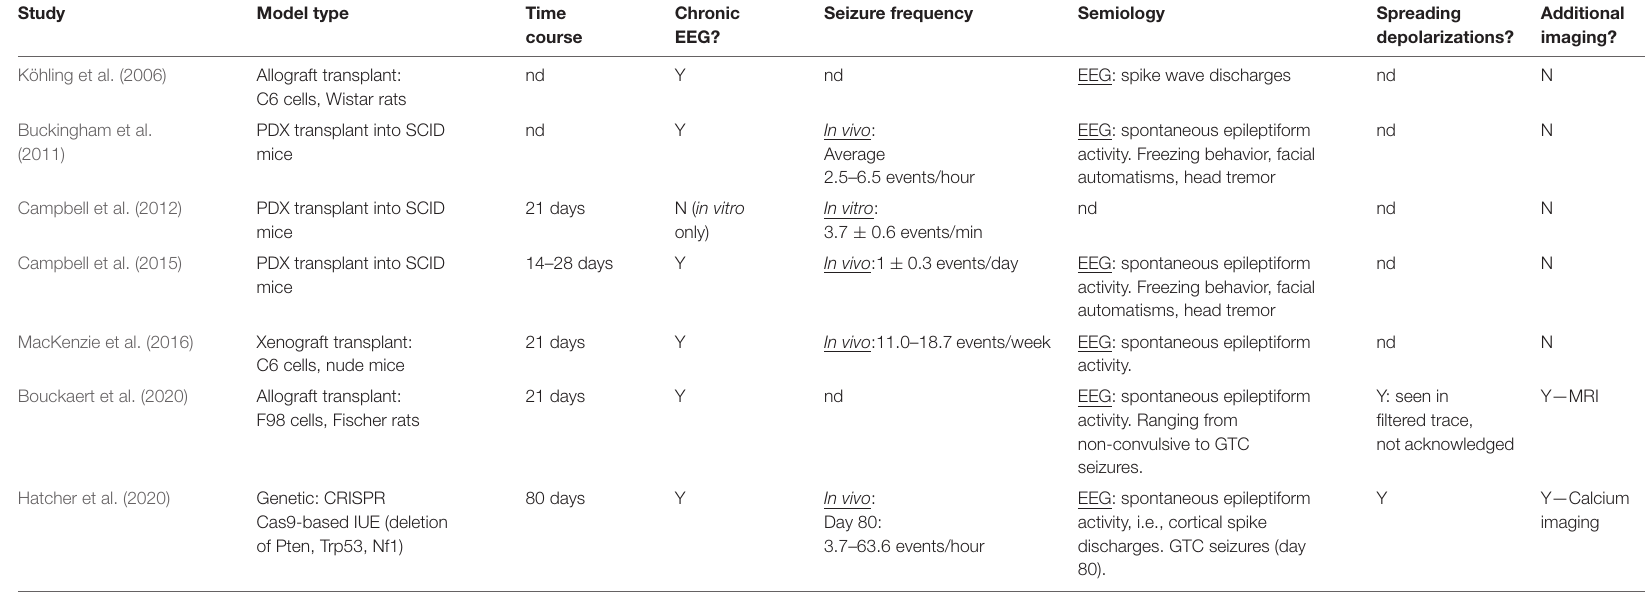
TABLE 2 | Seminal experimental studies, with a primary objective of GBM-associated epilepsy